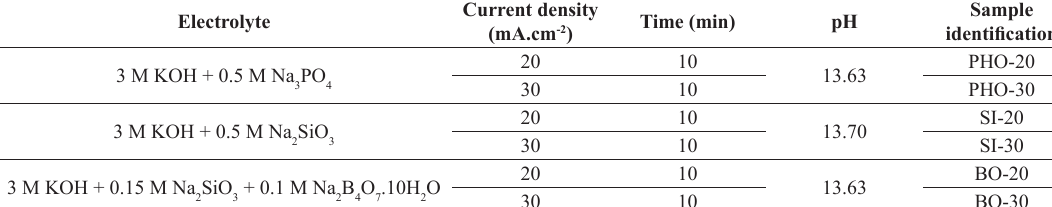
Table 2. Anodization parameters and sample designation.